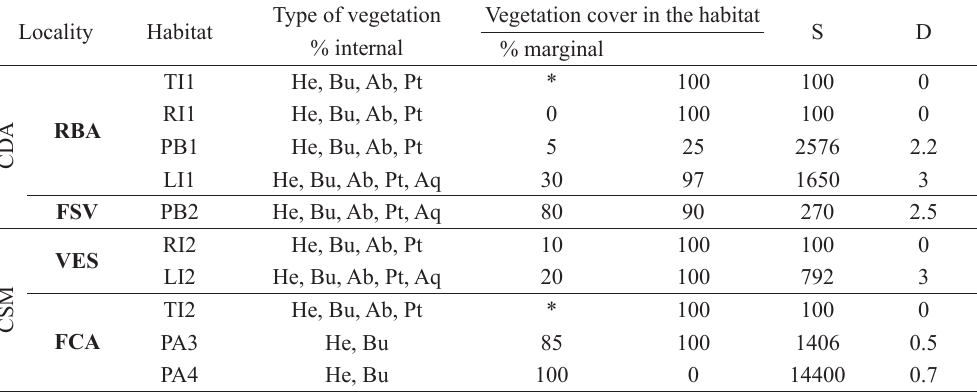
Characterization of the habitats sampled in the areas CDa and CsM, located in the mid northern region of the state of Paraná, between september 2011 and March 2012. regarding the acronyms, the first letter indicates the type of habitat sampled (T = transect; P = pond; L = lake and S = stream); the second indicated the physiognomy in which the habitat in inserted (I = interior of the forest; E = edge of the forest; O = open area). Type of vegetation: He = herbaceous; Bu = bushes; Ab = arboreous; Pt = pteridophytes; Aq = aquatic. (*) = Not applicable. Values of size (S) shown in square meters and of average depth (D) in